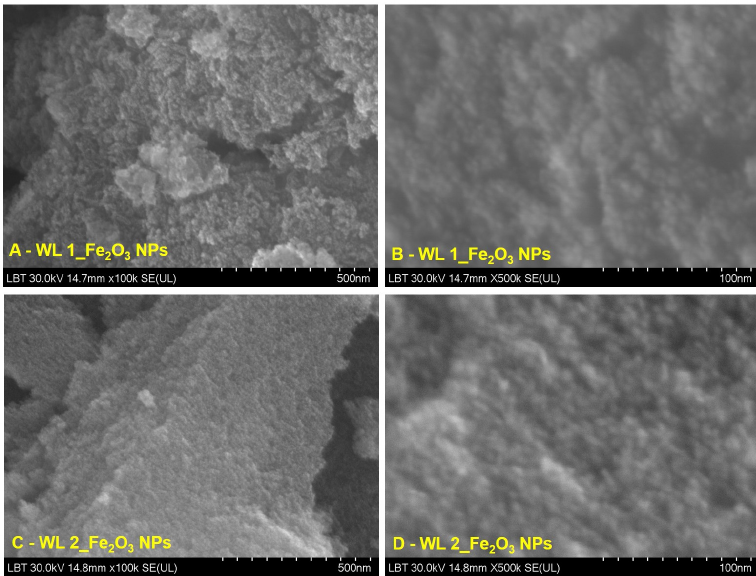
Figure 5. SEM images of IONPs obtained from wormwood leaves aqueous extract (WL 1–at 80 °C and WL 2–at 25 °C), at different orders of magnitude: ( A , C ) 500 nm scale bar, ( B , D ) 100 nm scale bar.